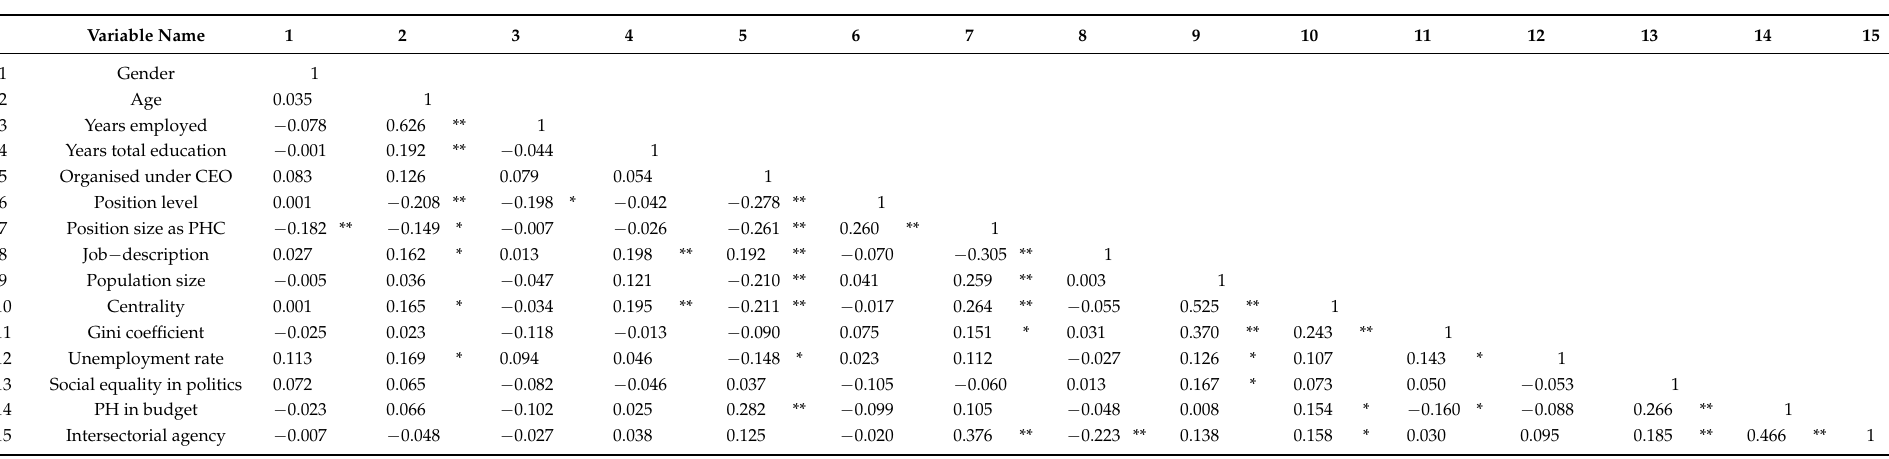
Table 3. Correlations between variables in the